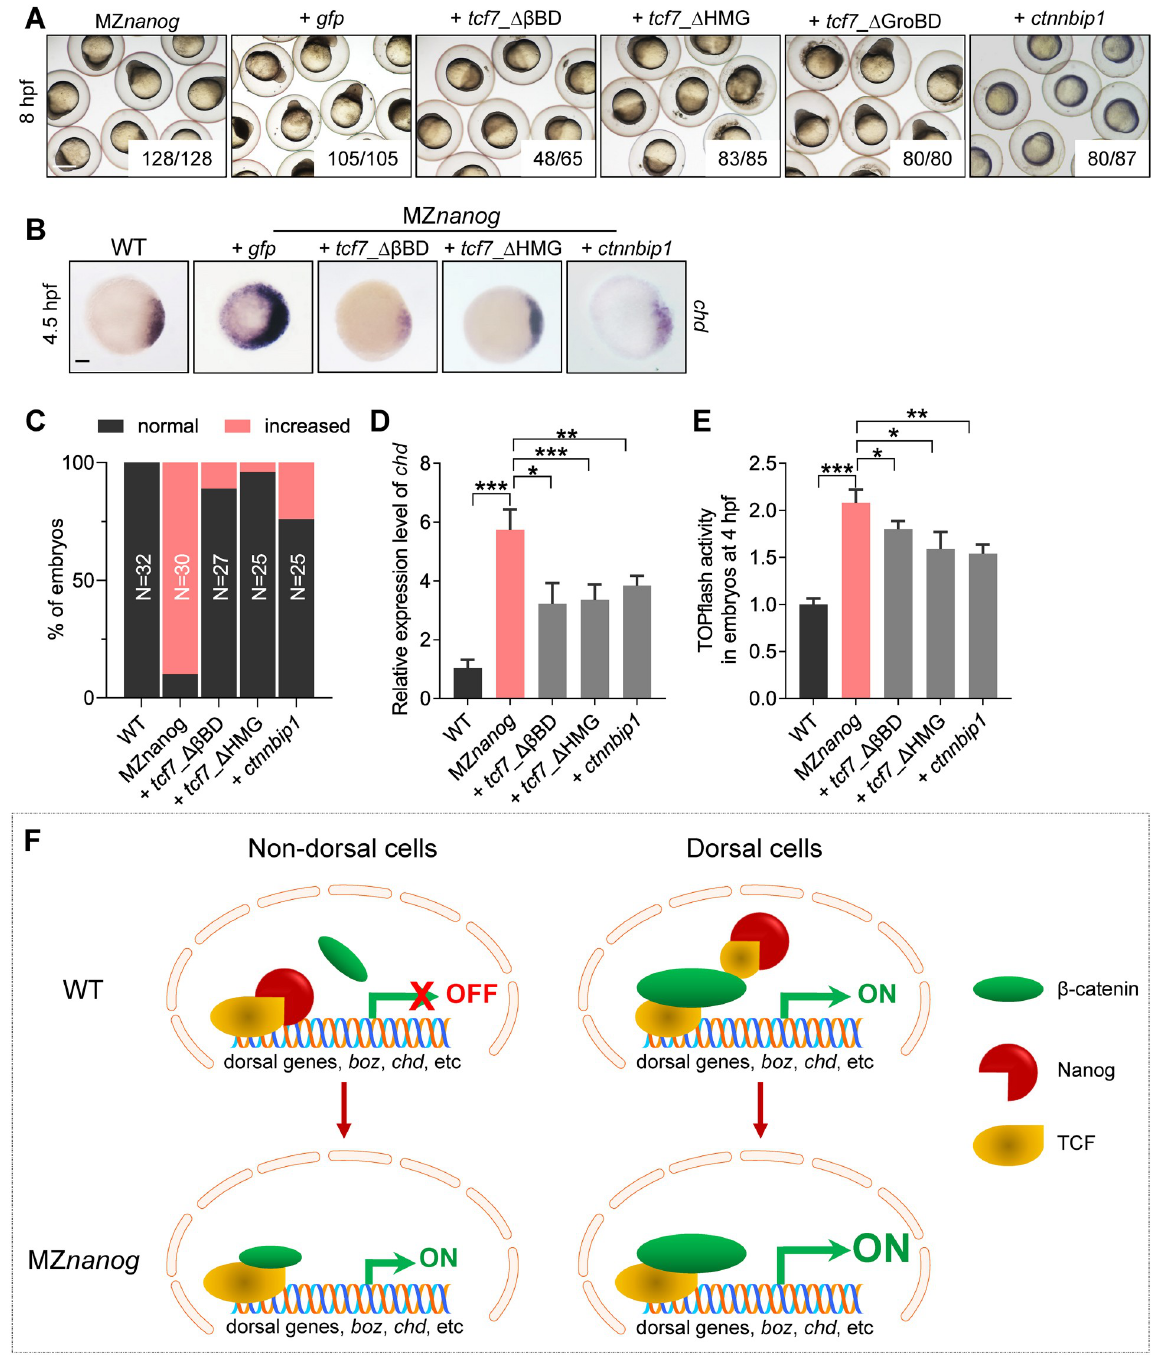
Fig 8. Confrontation of the β -catenin transcriptional activity in nucleus rescues the developmental defect of MZ nanog . (A) Injection of tcf7 )_ Δβ BD, tcf7 _ Δ HMG, or ctnnbip1 mRNA rescued the early developmental defects of MZ nanog , whereas overexpression of tcf7 _ Δ GroBD did not. Phenotypes were observed at 8 hpf. At least 50 embryos were injected, and 3 independent experiments were performed. The numbers below the morphology pictures mean number of embryos showing representative phenotype/total number of embryos. Scale bar, 500 μ m. (B) WISH analysis showing excessive and ectopic expression of chd in MZ nanog was rescued by overexpression of tcf7 )_ Δβ BD, tcf7 _ Δ HMG, or ctnnbip1 at 4.5 hpf. Scale bar, 100 μ m. (C) Statistical analysis of the embryos in panel B. N represents analyzed embryo number. (D) Relative mRNA level of chd in embryos of WT, MZ nanog , and MZ nanog injected with tcf7 )_ Δβ BD, tcf7 _ Δ HMG, or ctnnbip1 mRNA at 4.5 hpf examined by RT-qPCR. Error bars, mean ± SD, � P < 0.05, �� P < 0.01, ��� P < 0.001. (E) Relative β -catenin transcriptional activity in embryos of WT, MZ nanog ,